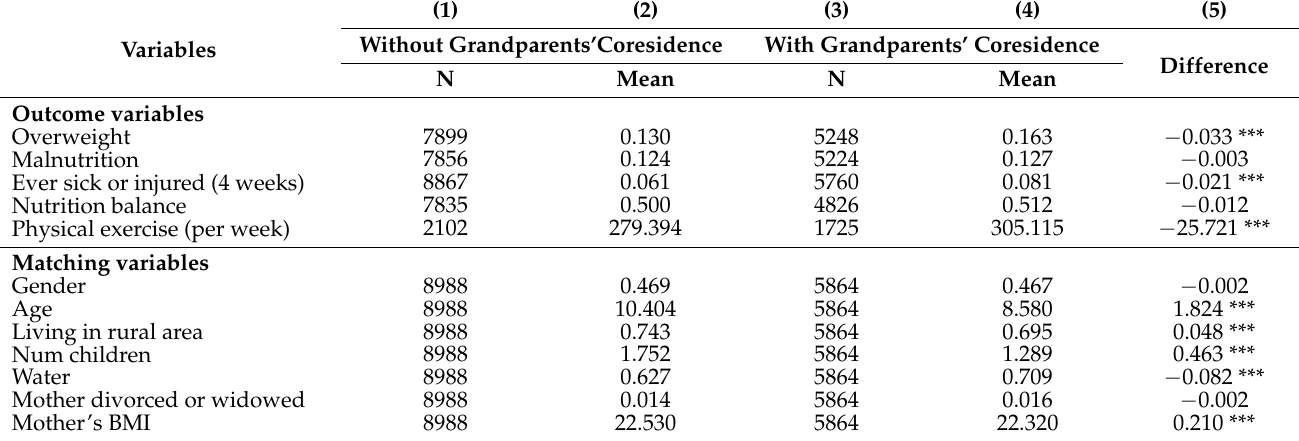
Table 2. Descriptive statistics and two-sample t -tests for the difference in means.